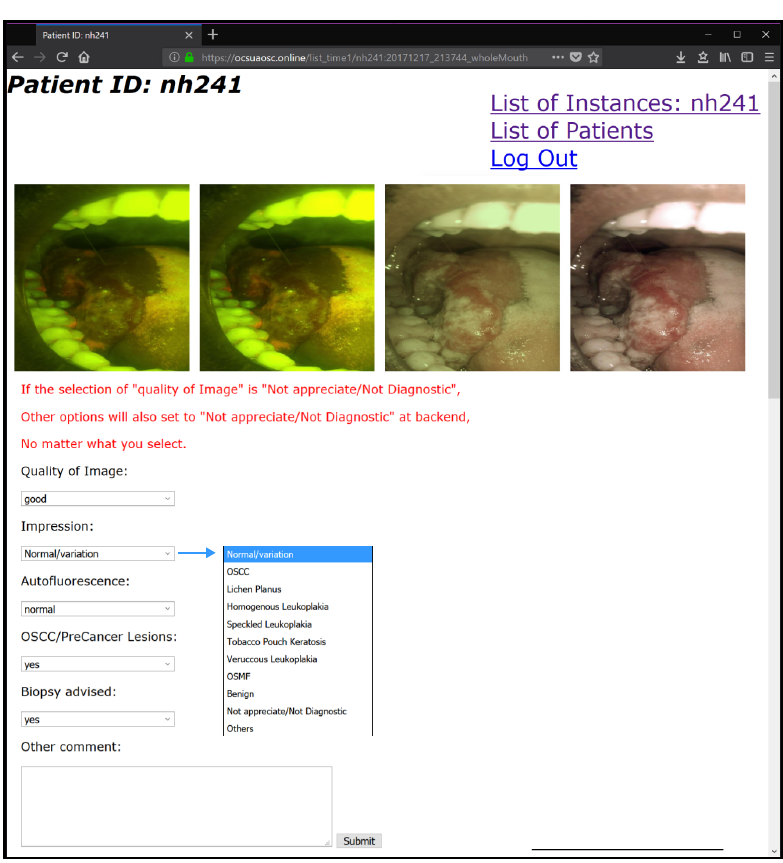
Fig 7. Sample web portal screen for remote viewing and diagnosis of images. The four images presented from left to right are: (i) original AFI, (ii) AFI with histogram equalization, (iii) original WLI, (iv) WLI with color